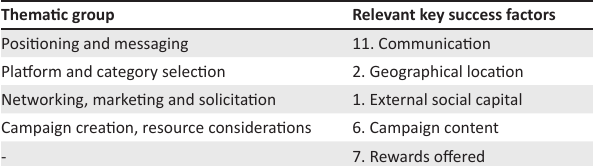
FIG URE 2: Semantic relational framework. TABLE 1: Thematic relation to key success factors. Thematic group Relevant key success factors Positioning and